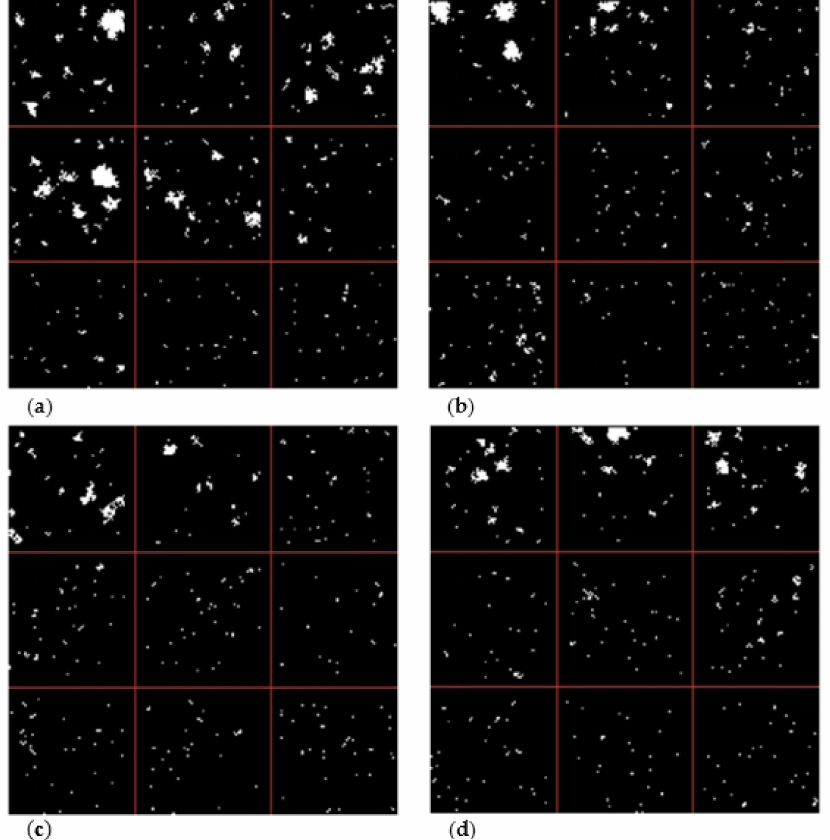
Figure 5. Simulation results: ( a ) Mainly seeking model with N = 20, α = 1.2, and T = 15, ( b ) Mainly neutral model with N = 20 and T = 15, ( c ) Mainly averse model with N = 20, α = 1.2, and T = 15, and ( d ) Equalizing model with N = 20 and T =